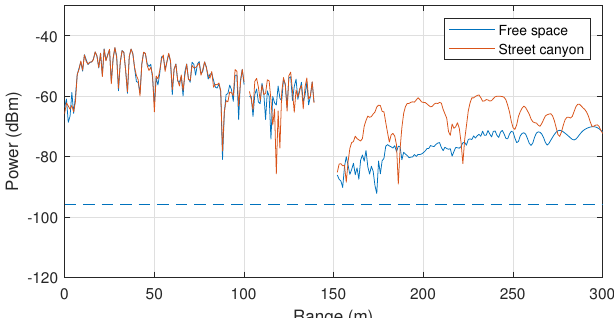
Figure 14. Scattering on vehicles. Distribution of the signal level at the height of 1.5 above the